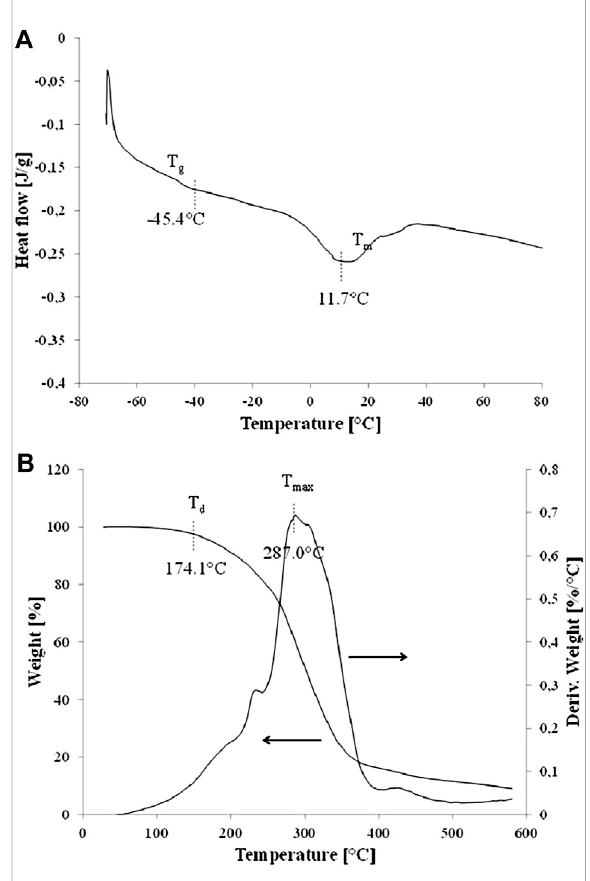
DSC curves (A) and TG curves (B) of P(3HB-co-3HHx-co- 3HO-co-3HD-co-3HDD) extracted from the Pseudomonas sp. GL06 cells at 48 h cultured in the